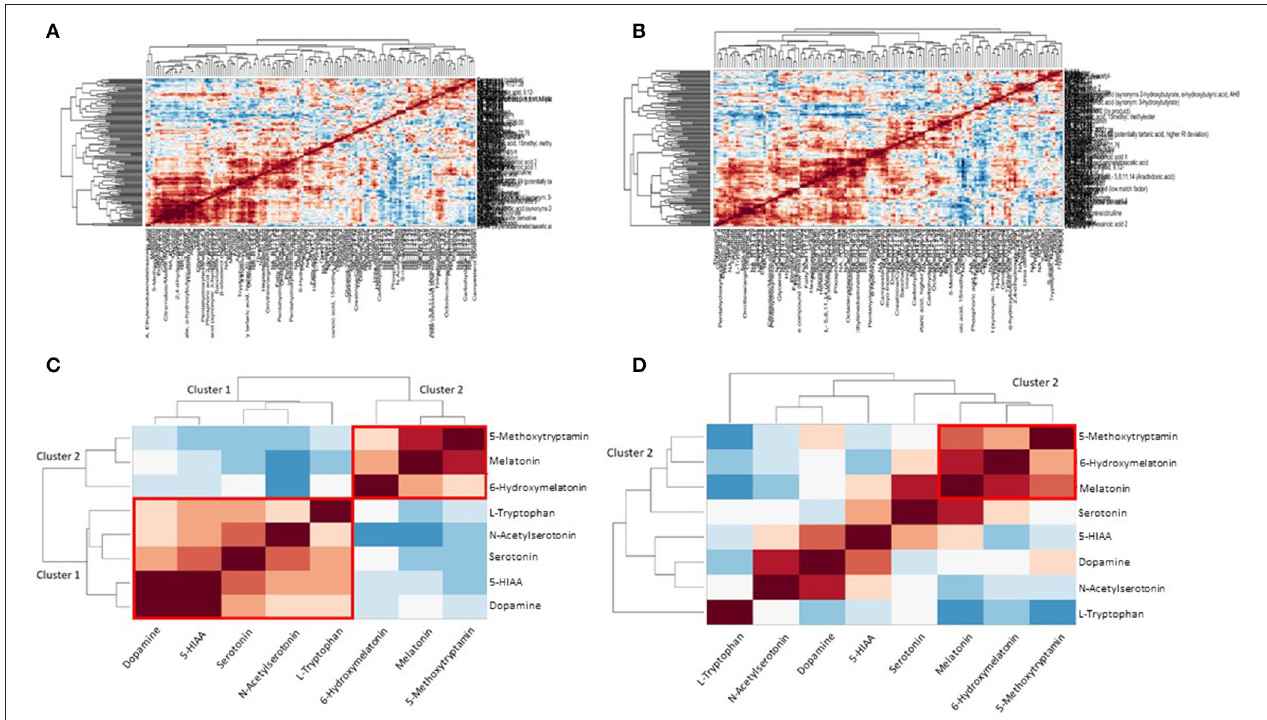
FIGURE 3 | Metabolite correlation network analysis visualized as clustered correlation coefficient matrix. (A) Clustered heat map shows a significant metabolic signature of control samples. (B) GDM case show a different pattern compared to the control samples indicating a dramatic reprogramming of metabolism in GDM disease. (C) Detailed view of serotonin/melatonin metabolites in urine samples of control. Cluster 1 is a highly correlated serotonin cluster and cluster 2a highly correlated melatonin cluster in normal metabolic conditions. (D) Detailed view of serotonin/melatonin metabolites in urine samples of GDM case. Cluster 1 disappeared in GDM cases and cluster 2 is conserved from control to GDM.